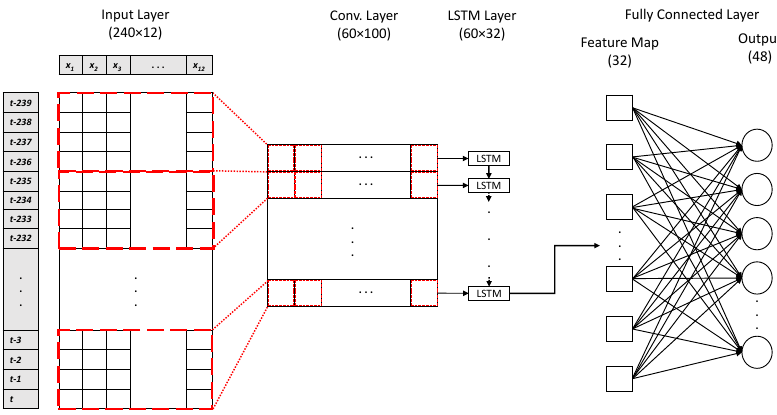
Figure 6. CNN-LSTM model architecture with filter and stride size of